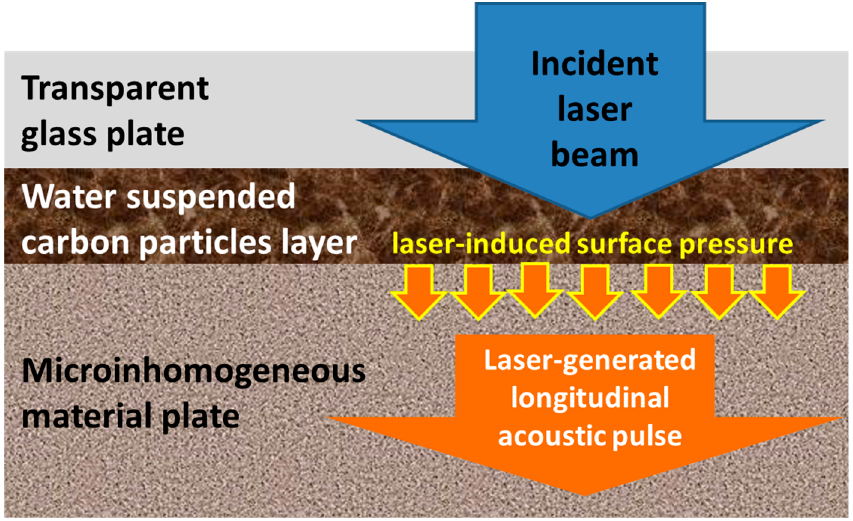
Figure 1 . Diagrammatic sketch of the processes taking place when laser irradiates the liquid layer constrained by a transparent solid.